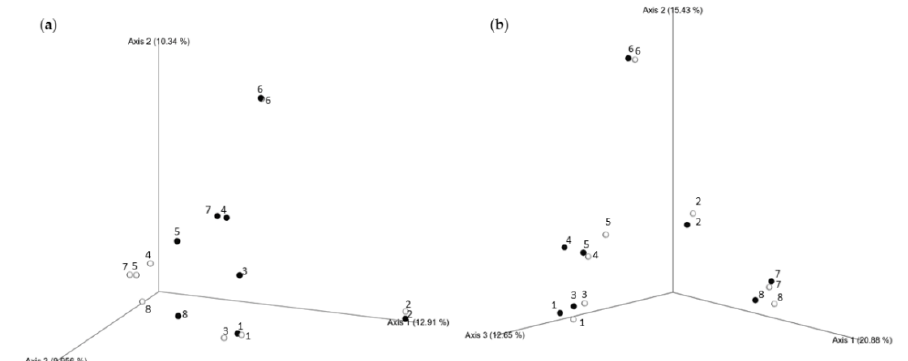
Figure 8. Principal Coordinates Analysis (PCoA) of seasonal microbial biodiversity changes using Bray-Curtis distance. Seasonal relationships and distribution of bacteria ( a ) and fungi ( b ) identified across samples collected from Pergola surfaces in summer ( ○ –white spheres) and winter (●–black spheres).